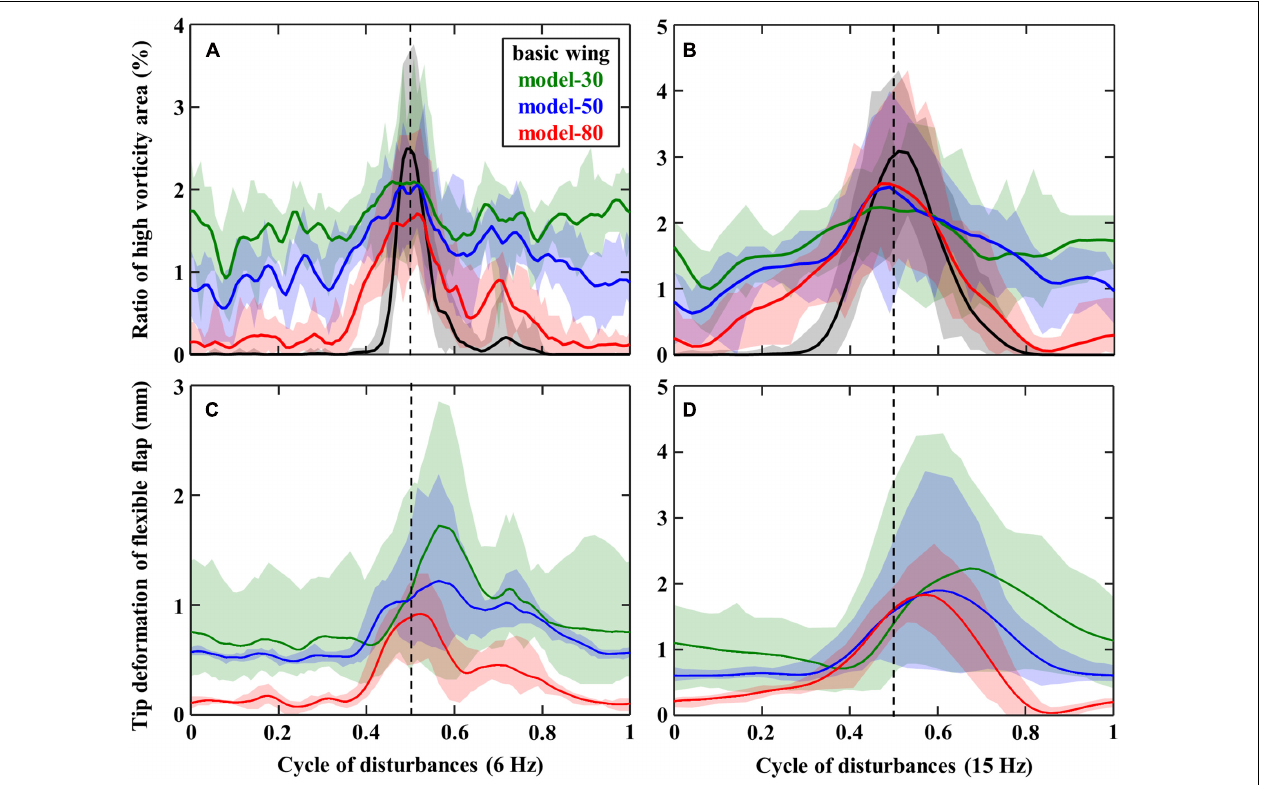
FIGURE 7 | Time-series of panels (A,B) the ratio of high vorticity area and panels (C,D) the deflection of the tip of flexible flaps in the disturbance of panels (A,C) 6 Hz or (B,D) 15